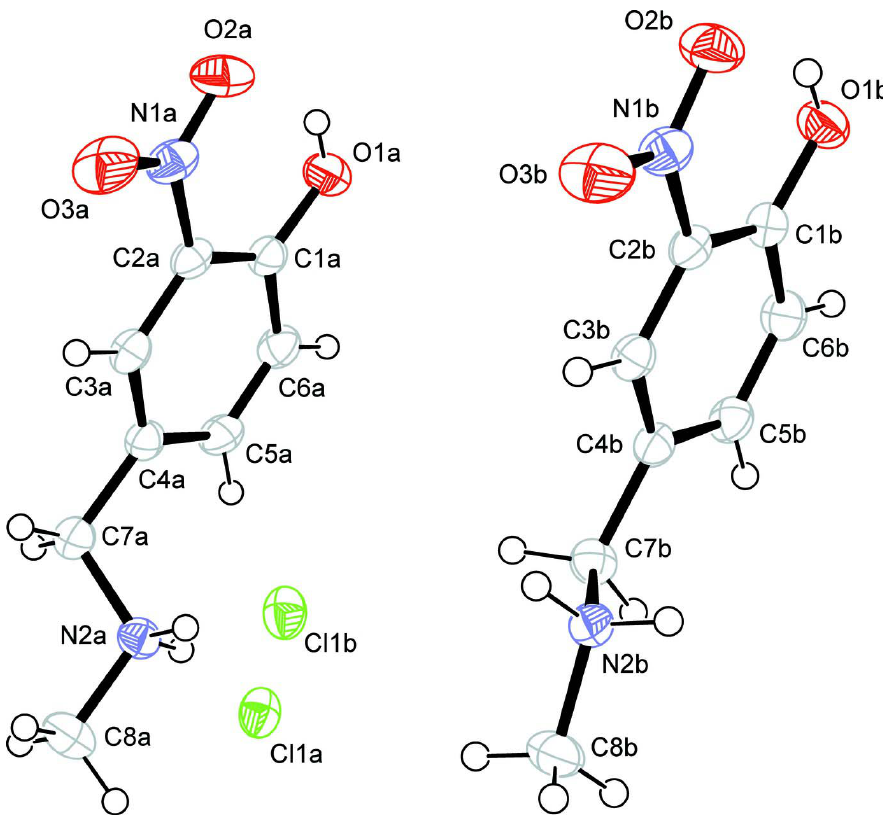
Figure 1 The asymmetric unit showing ellipsoids at the 50% probability level and the numbering scheme employed.